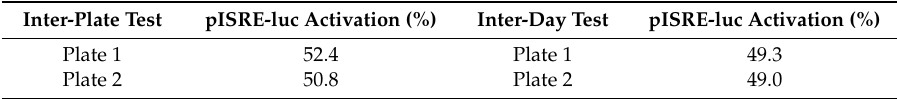
Table 2. Inter-plate and Inter-day tests for VP24 inhibition